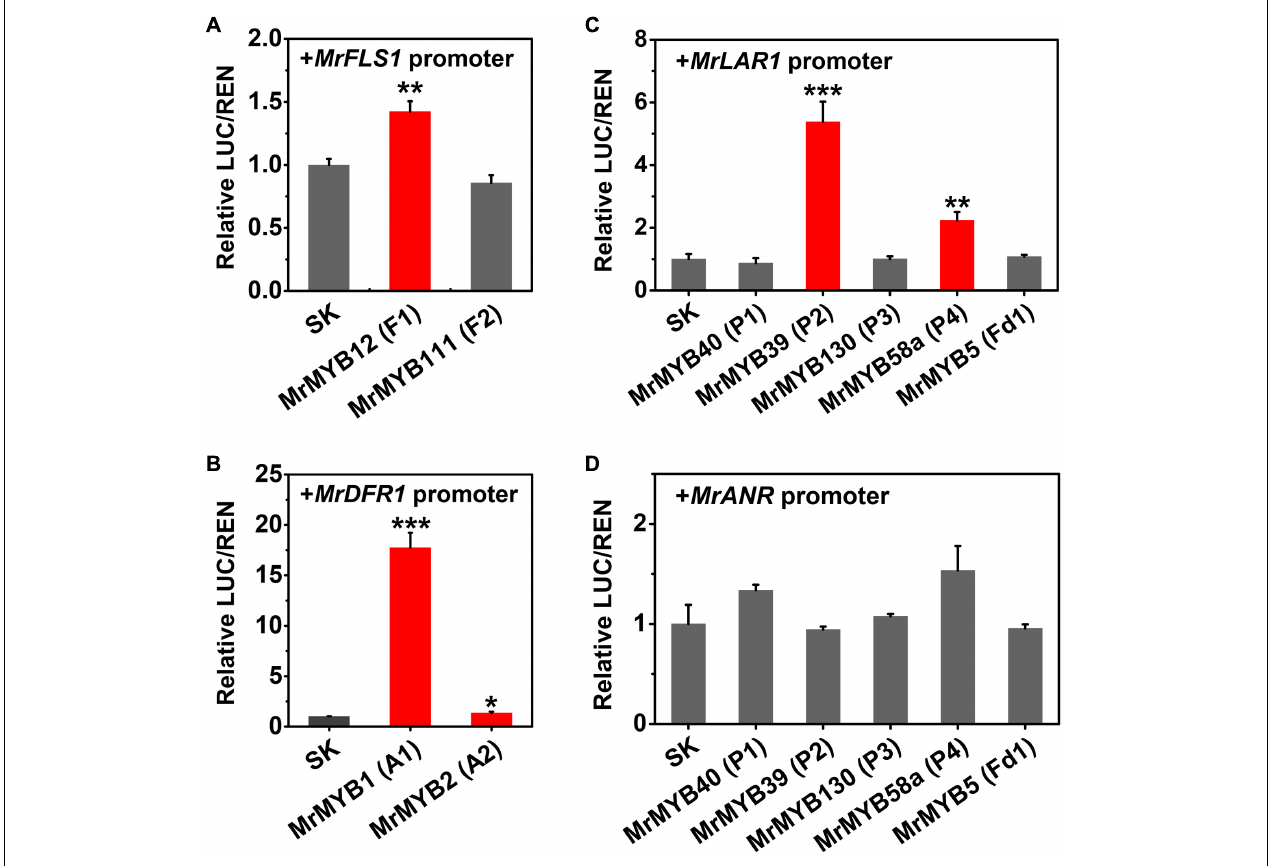
FIGURE 6 | Regulatory effects of flavonoid-related MrMYBs on the transactivation of the promoters of MrFLS1 (A) , MrDFR1 (B) , MrLAR1 (C) , and MrANR (D) . The ratio of LUC/REN of the empty vector plus promoter was set as 1. SK refers to the empty pGreen II 0029 62-SK vector. Error bars indicate SEs from six replicates (* P < 0.05, ** P < 0.01, and *** P <